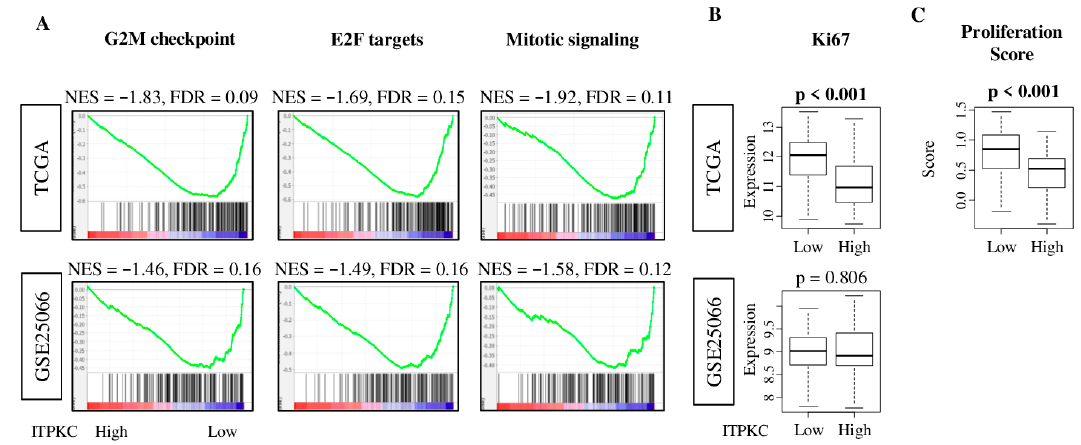
Figure 4. Hallmark gene sets with significant enrichment in low- ITPKC group of TNBC in both TCGA and GSE25066 cohorts. ( A ) Gene set enrichment plots along with NES and FDR of gene sets: G2M checkpoint, E2F targets and mitotic signaling. NES and FDR were determined with the classical GSEA method. ( B ) MKI67 gene expression in the low- and high- ITPKC expression groups of both cohorts. ( C ) Boxplots of proliferation score between low and high ITPKC expression in the TCGA cohort. The top quartile was defined as the high-score group within each cohort. One-way